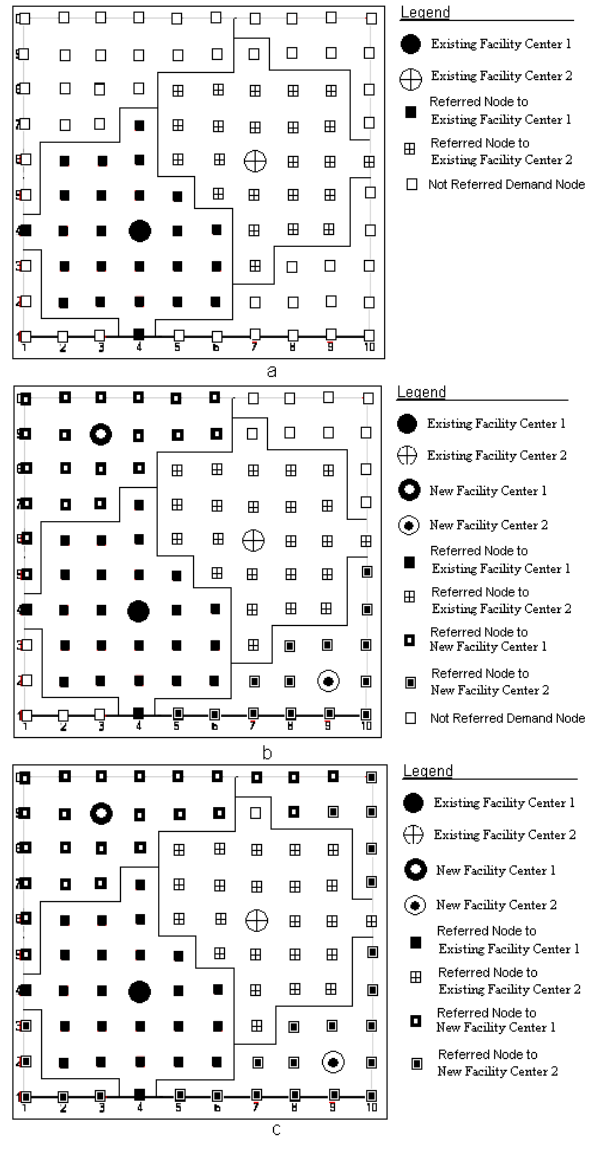
Fig. 4. Steps of traditional method